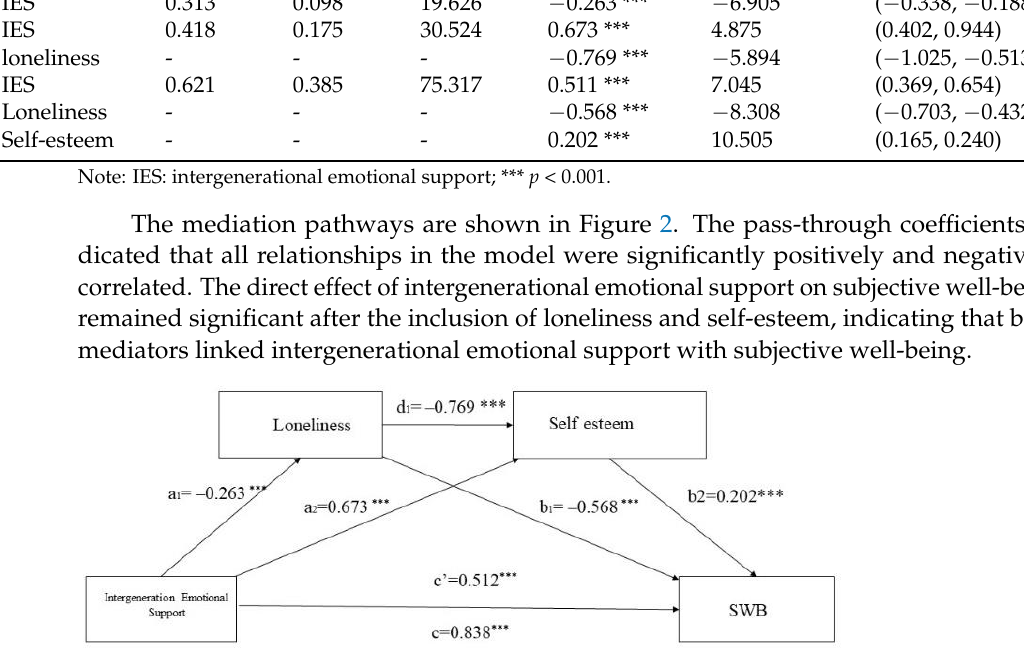
Figure 2. Conceptional framework of the multiple mediation model. Note: *** p < 0.001. Note1: a1: represents the path from IES to loneliness; a2: represents the path from IES to; b1 represents the path from loneliness to SWB; b2 represents the path from Self-esteem to SWB; d1 represents the path from loneliness to Self-esteem. Note2: SWB represents subjective well-being.